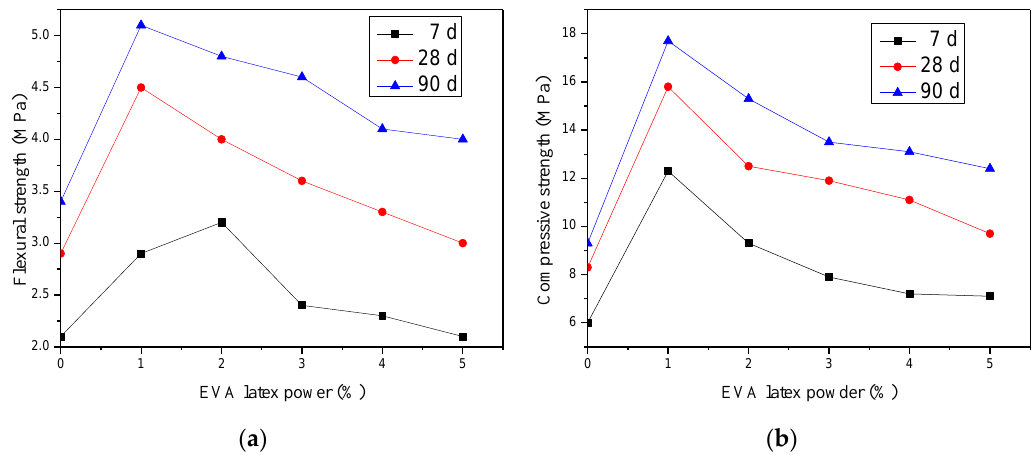
Figure 7. Influence of EVA on the mechanical properties of mortars: ( a ) flexural strength, ( b ) compressive strength. It can be seen from Figure 7 that for the different age groups, the effect of EVA content on the strength of the mortar was roughly the same. The addition of a small amount of EVA can increase the flexural and compressive strength of the mortar. For the different age groups, the compressive strength of the mortar was highest when the EVA content was 1%, which corresponds to the effect of the EVA content on the dry density in Figure 6. The dry density of the mortar with 1% EVA content was the largest, and the test block was the most compact. Hence, the strength was also the highest. A small amount of EVA forms a polymer film in the pores. This polymer film has toughness and elasticity. When the mortar is subjected to external forces, the interwoven polymer film would relieve the internal stress of the mortar, thereby reducing the strain. Nazia Tarannum [45] agrees that the polymer has a function similar to the mobile joint between particles of cement mortars, which can reduce the stress and improve the resistance to deformation. Figure 8 shows that compared with the control mortar without EVA, the micro cracks of mortars with 2% EVA content significantly decreased. The polymer membrane filled the pores of the hydration product, making the structure more compact, but there were still some large pores. Figure 8. The scanning electron micrograph of the mortar: ( a ) the control, ( b ) the mortar with 2% content of EVA. For the increase in content of EVA, the air-entraining effect of the EVA is reflected, and the porosity of the mortar is increased. This effect is much greater than the cohesion